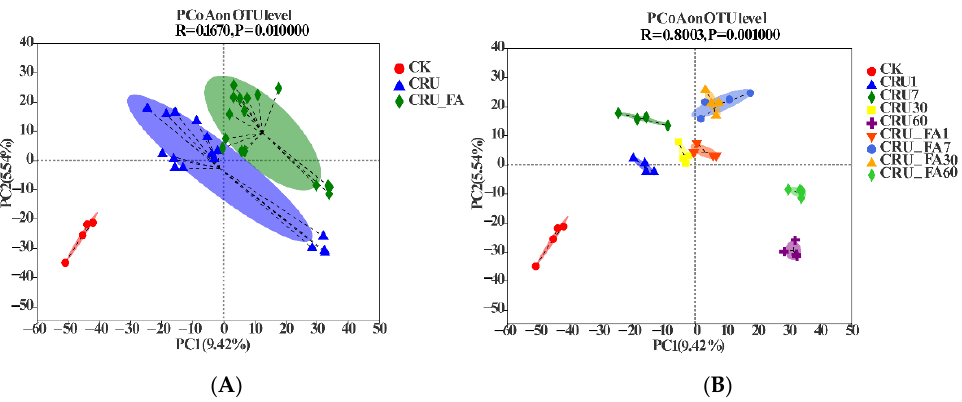
Figure 1. Principal coordinate analysis (PCoA) based on the weighted UniFrac distance matrix from different treatments ( A ) and different incubation days ( B